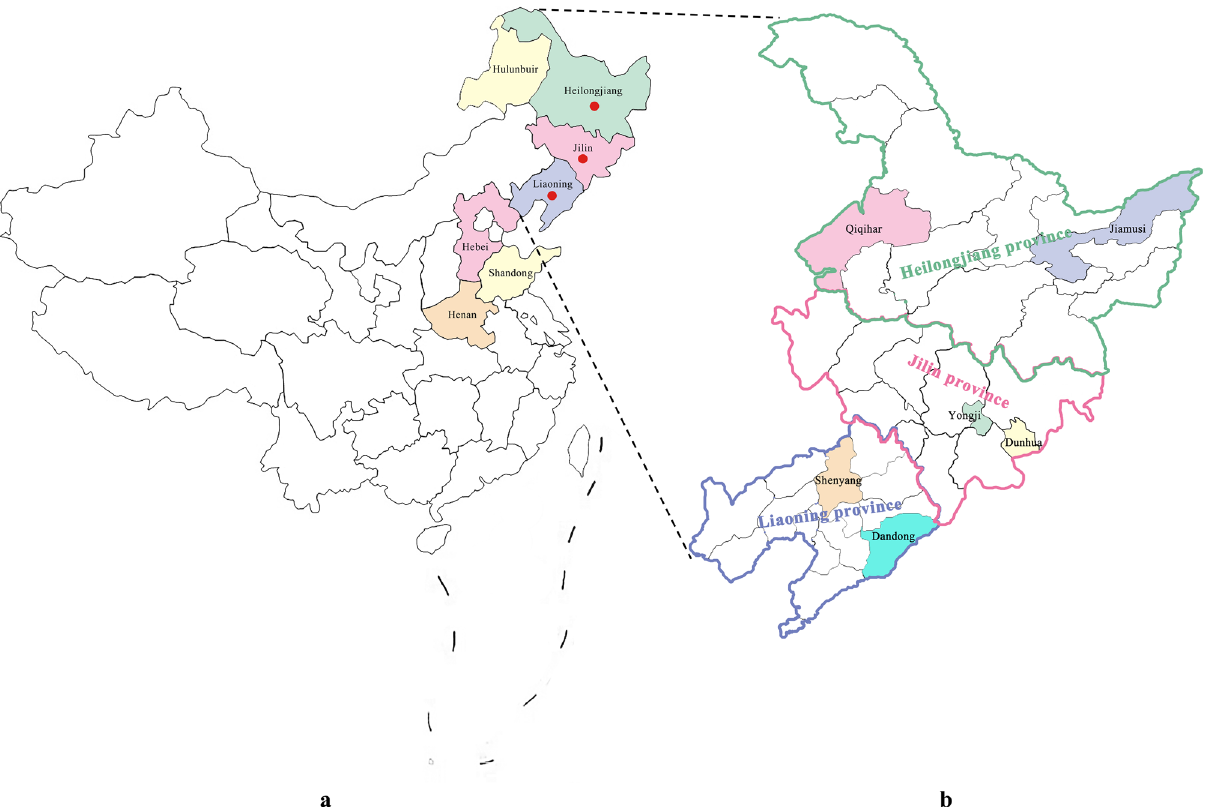
Figure 1. Maps of locations used in this study. ( a ) Map of locations used for distribution investigation. Red circles indicate the distribution areas of Rhynchaenus maculosus ; ( b ) Map of locations used for